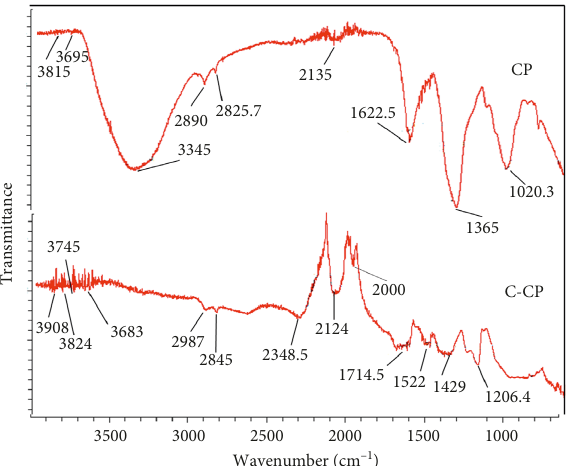
Figure 6: A comparative FT-IR analysis of native (CP) and citric acid-modified (C-CP) Citrullus lanatus peels.